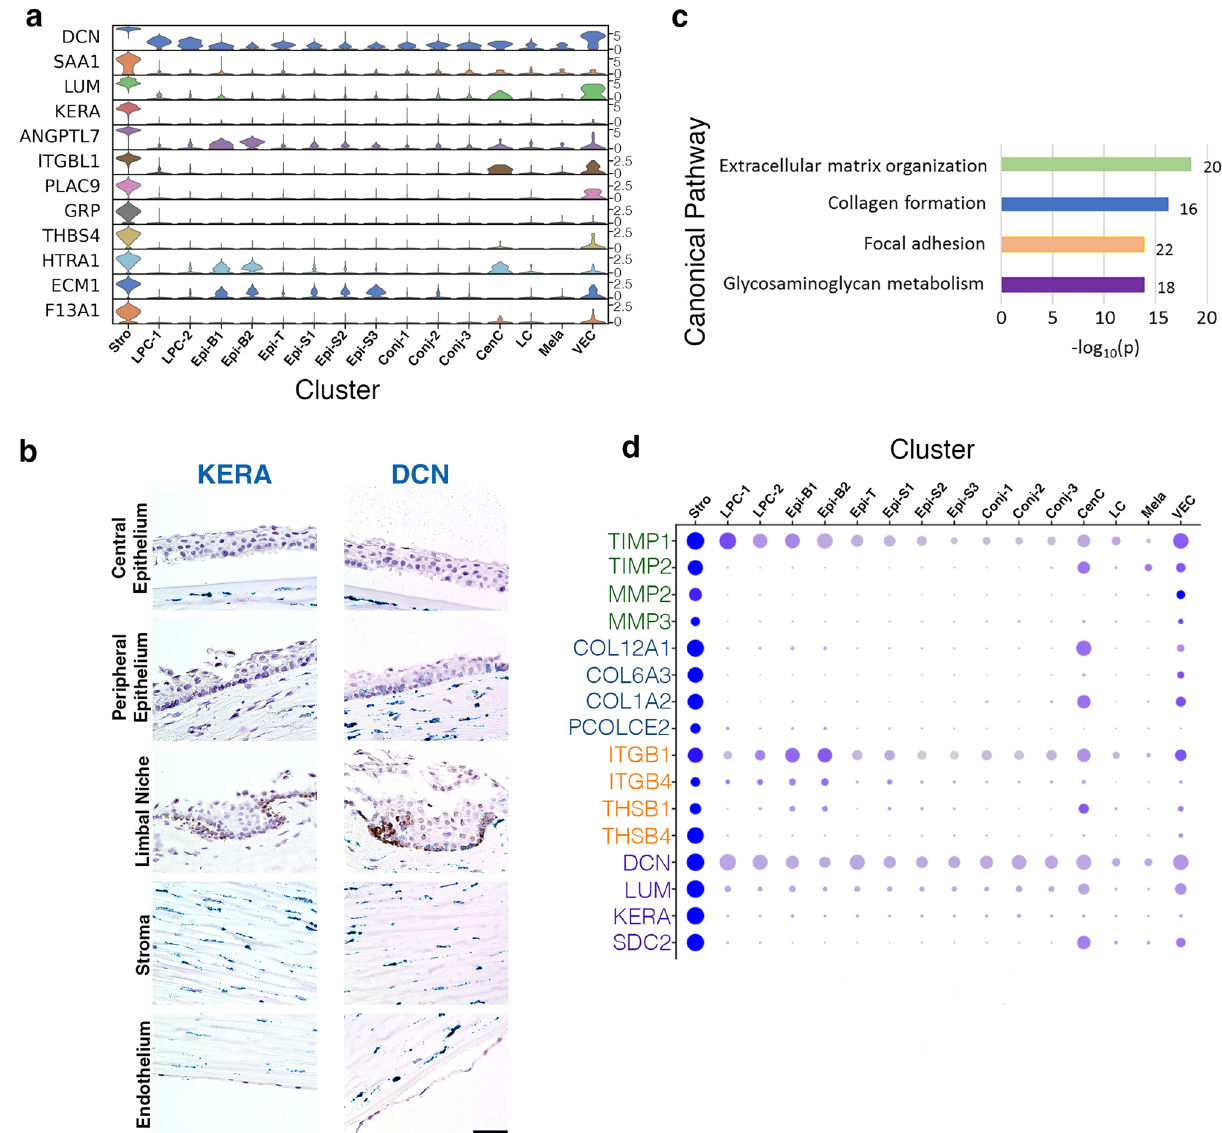
Figure 3. Molecular characteristics of corneal keratocytes. (a) Violin plots of stroma (Stro) marker gene expression. SCANPY 1.7.1 in Python was used to generate the violin plots as indicted in the “Materials and methods” (https:// pypi. org/ proje ct/ scanpy/). (b) RNAScope on human cornea of stroma keratocyte specific and enriched gene KERA and DCN (scale bar: 50 uM). (c) Topmost enriched MSigDB Canonical Pathways of genes up-regulated in Stro compared to other clusters. The number of overlap genes are indicated next to each bar. (d) Expression of representative pathway overlap genes identified in (c) with the circle diameter representing number of cells expressing the gene, and color saturation reflecting the level of expression. Color coordination represents the genes in ( d) by their canonical pathway in (c)